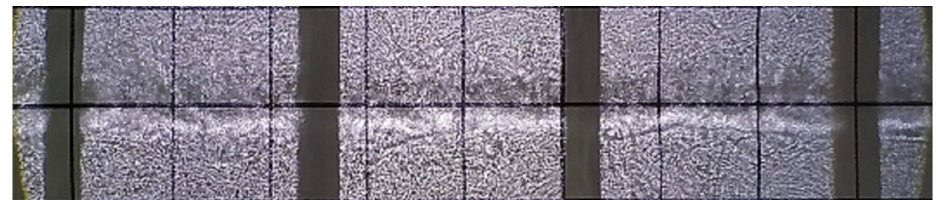
Figure 13. The shadowgraph image of the density interface received nearly at the same time as the salinity profile at Figure 12 ( Ri initial = 100; Re = 214 ).